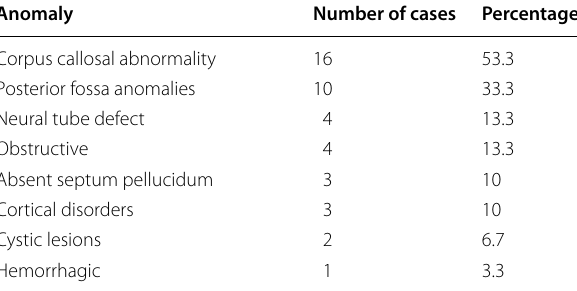
Table 2 Number of cases grouped according type of malformation